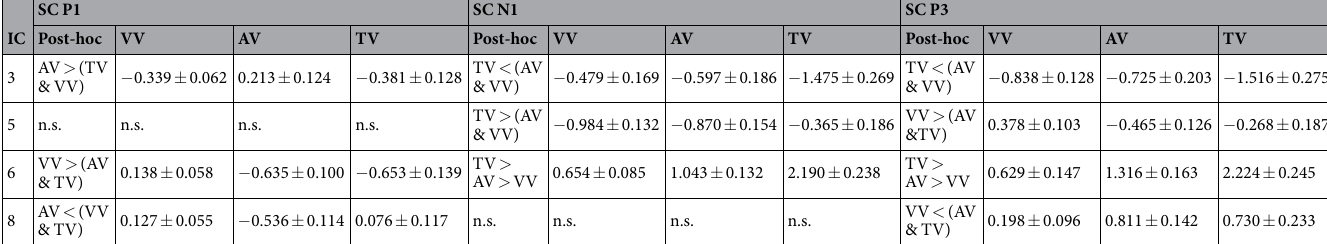
as the proprioceptive input from the tactile stimuli was first encoded in an egocentric space and then needed to be transferred to the allocentric reference system of the paradigm. Taken together, this allows for the conclusion that both multimodal information integration (indicated by differences between uni- and bimodal task versions) and modality-specific aspects of information processing (indicated by differences between all three task ver- sions, especially the two bimodal ones) may confound measures of multicomponent behavior. Furthermore, we found no effects of task version on simple Go trials, which proves that the participants’ baseline performance was